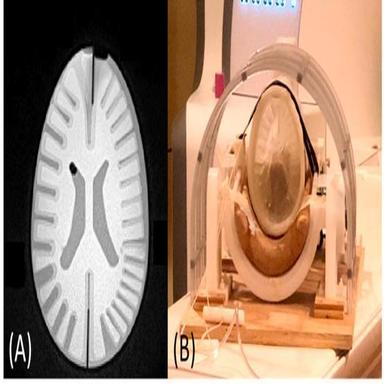
(A) FLAIR image showing an axial cross-section of the ANGUS phantom. The image shows good contrast between the components of ANGUS that model the CSF (dark gray), cortical gray matter (medium gray), and white matter (light gray). (B) The ANGUS phantom was secured to the neck extension device in the same manner as has been used for healthy volunteers.